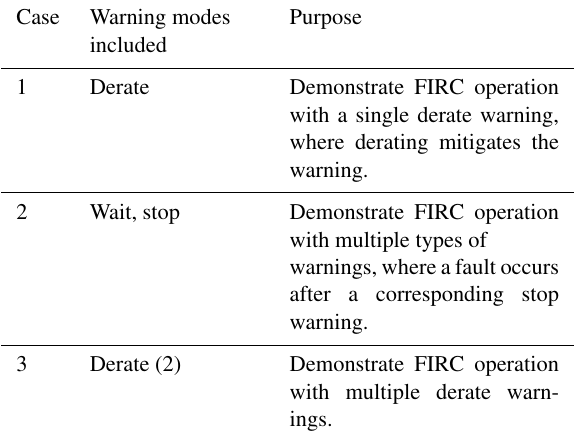
Table 3. Simulation cases demonstrating FIRC module